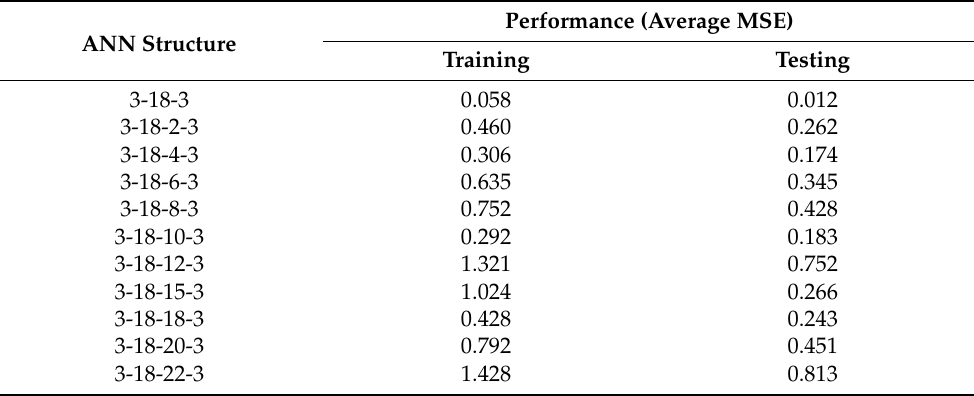
Table 4. The performance comparison of a two-hidden-layer ANN with various numbers of neurons in the second hidden